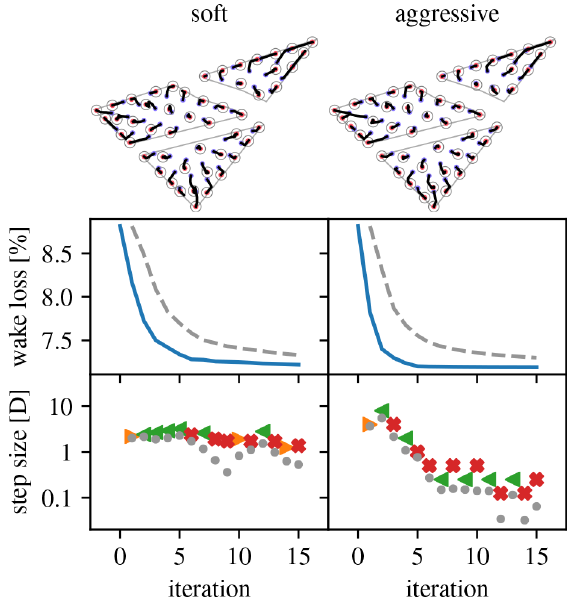
Figure 20. Overview of optimization runs for the Borssele IV wind farm layout problem, 50-turbine case. (Legend in Table